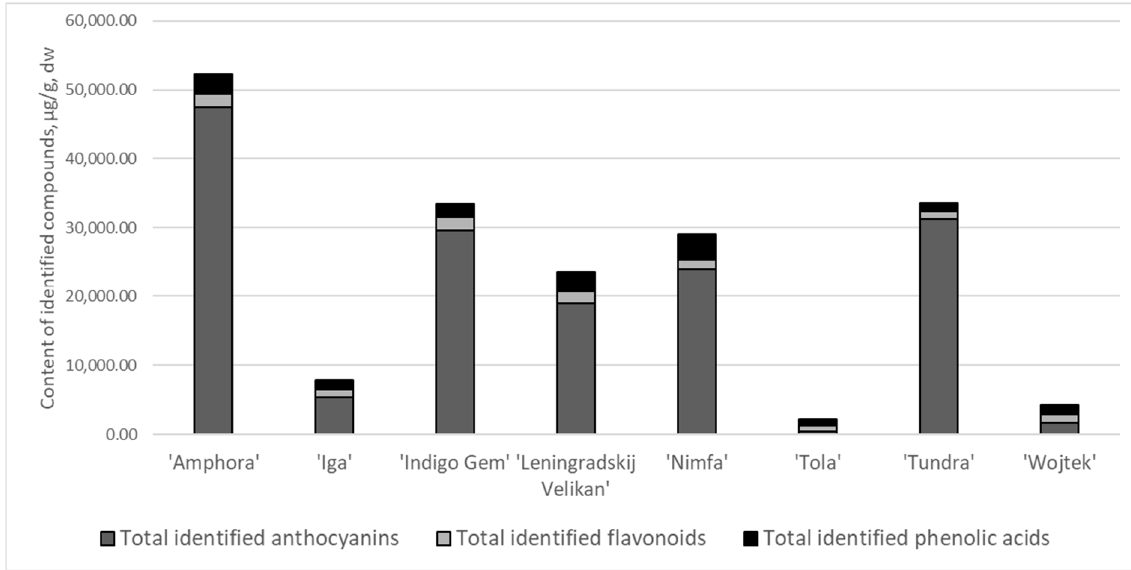
Figure 1. Content of total identified compound groups ( μ g/g DW) in L. caerulea fruits of different cultivars (flavonols, flavones and proanthocyanidns coupled to flavonoids).